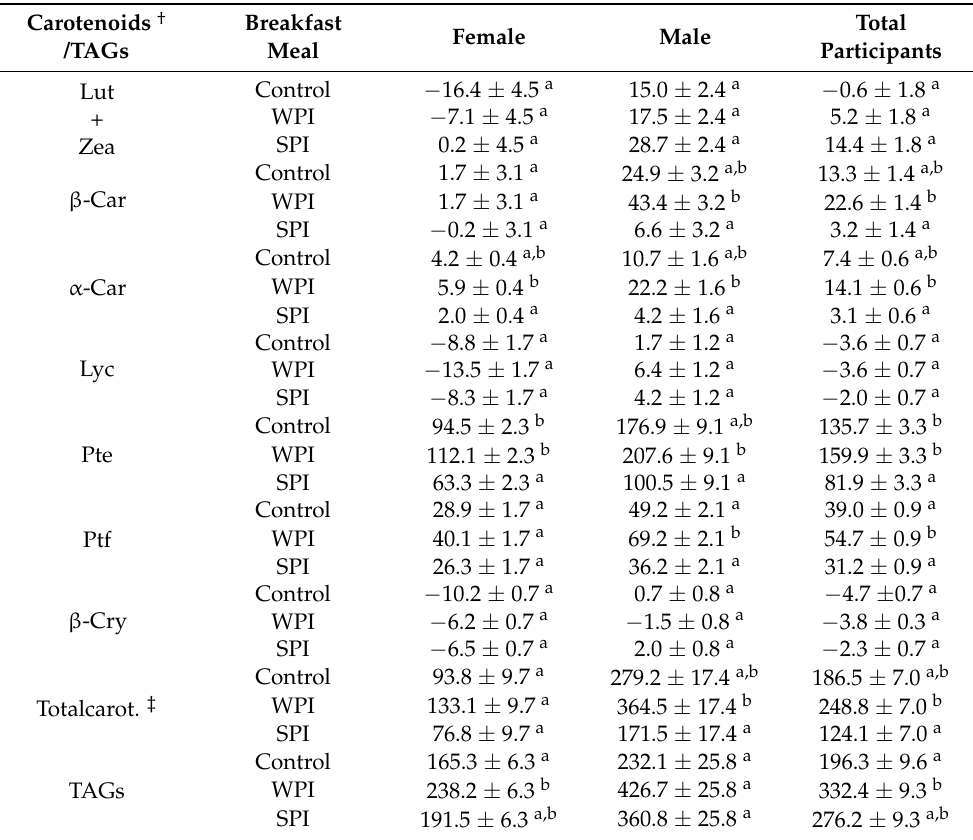
Values represent mean ± SEM. Means without a common superscript letter differ significantly, p < 0.05. Lut+Zea: lutein+zeaxanthin; β -Cry: β -cryptoxanthin; Ptf: phytofluene; Pte: phytoene; α -Car: α -carotene; β -Car: β